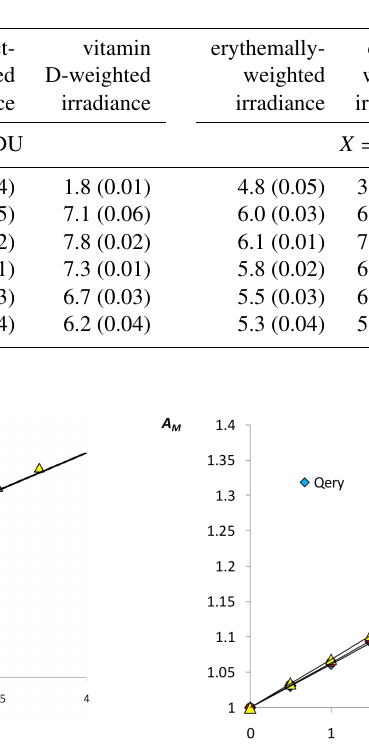
Table 1. Relative molecular gradients G bio (%km − 1 ) at different solar elevations and ozone content for different types of BAUVR. M(A = 0 ) Accurate model simulations. Surface albedo = 0. Determination coefficient R 2 is higher than 0.997 in all cases. The standard error of G bio is given in the brackets at P = 95%. M(A = 0 )